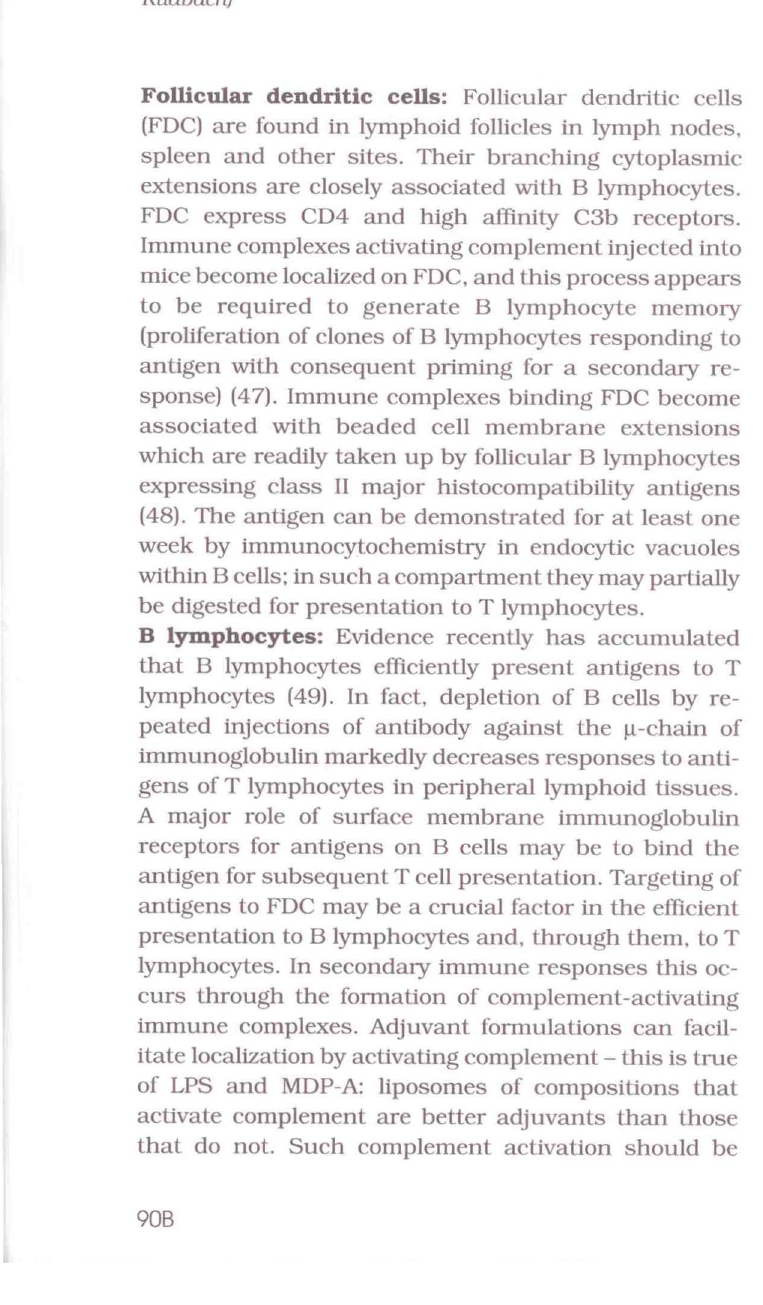
Figure 4) Structure of Lipid A. In monophosphoryl Lipid A. the phosphate group on the right side is missing (courtesy of Dr J Rudbach)